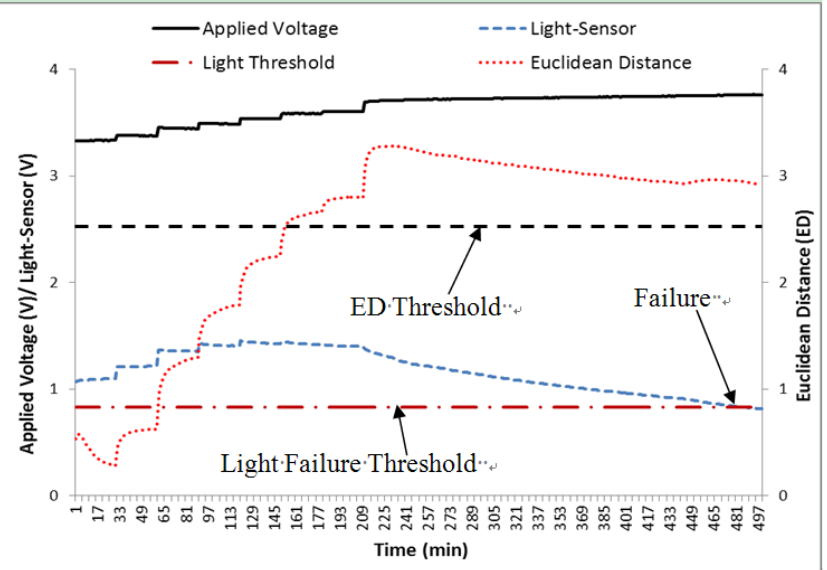
Figure 14. Demonstration of Euclidean